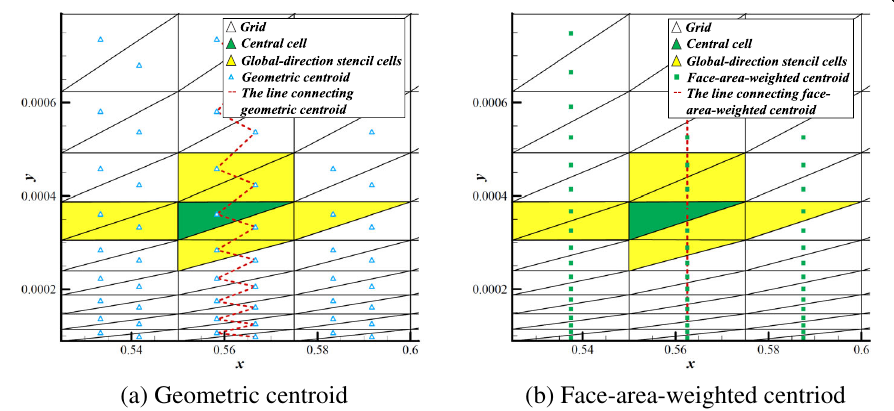
Fig. 9 Global-direction stencil cells combined with ( a ) geometric centroids and ( b ) face-area-weighted centroids on grid with the straight